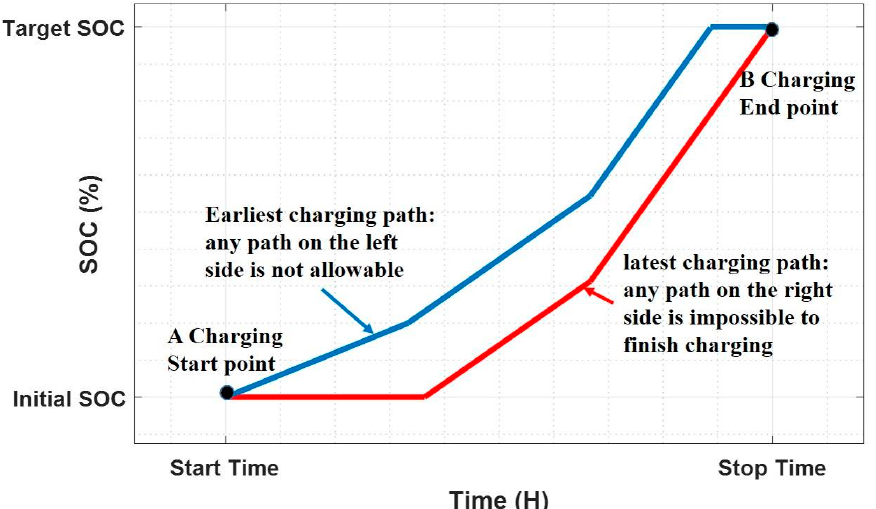
Figure 5. Envelope of PEV charging paths.